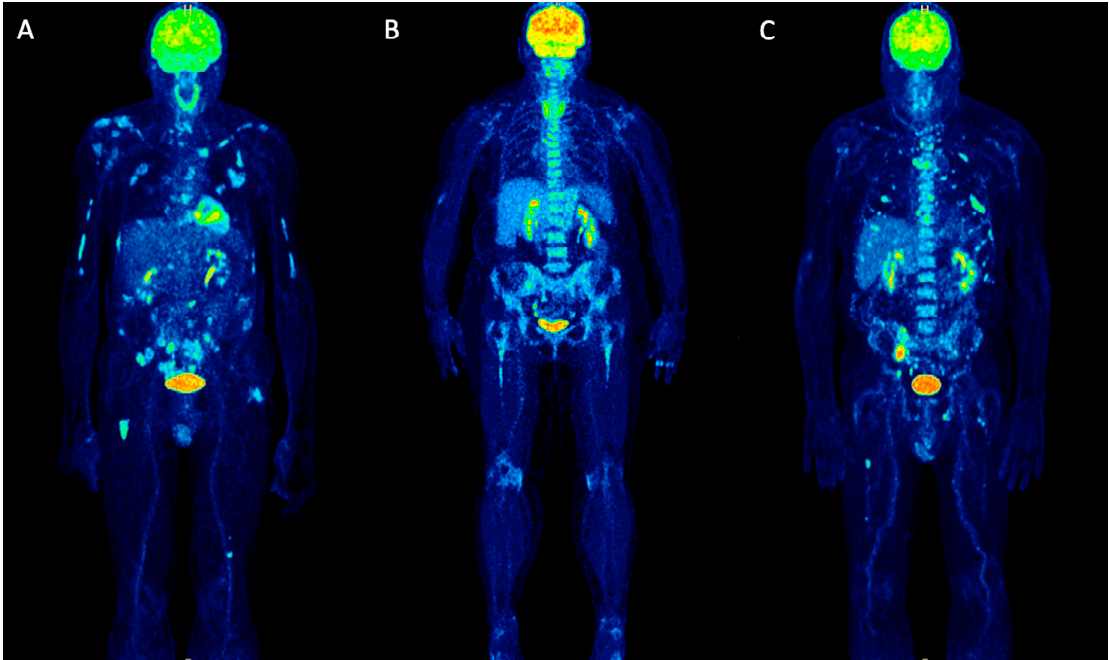
Figure 1. Maximum intensity projection (MIP) PET / CT images of newly diagnosed MM patients before treatment, representing examples of di ff erent pathologic patterns of 18 F-FDG uptake. ( A ) demonstrates a patient with multiple focal lesions in the skeleton. ( B ) depicts a patient with intense di ff use tracer uptake in the bone marrow of the axial skeleton and the proximal humeri and femora without clearly delineated focal lesions. ( C ) shows a patient with a mixed pattern of 18 F-FDG uptake with intense, di ff use uptake in the axial skeleton and multiple, focal bone marrow lesions.